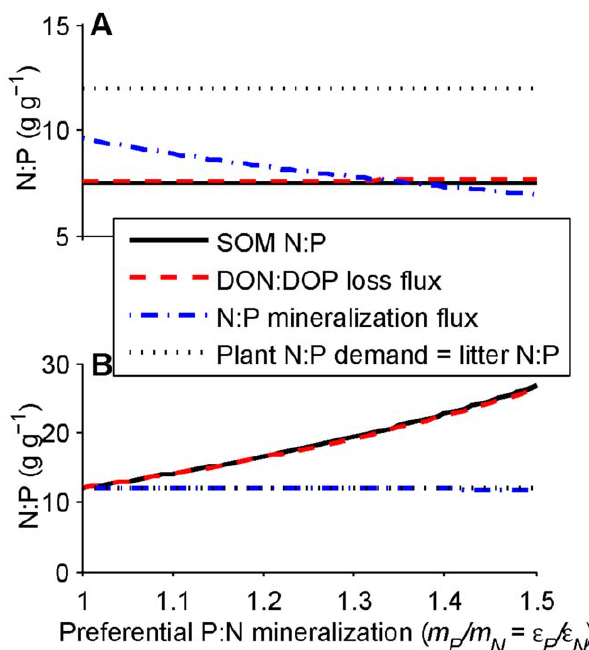
Figure 6. Effects of preferential P versus N mineralization. Effects are different for the (A) intermediate and (B) long timescales. Parameters are from Table 1 except for the mineralization rates m N and m P and the fractions of litter N and P decomposition mineralized, e N and e P , which vary to give the ratios along the horizontal axis. Timescale approximations of soil organic matter (SOM) N:P (solid black line), N:P losses of plant-unavailable nutrients from SOM and litter combined (termed DON:DOP in the legend for brevity, but in reality incorporating dissolved and particulate hydrologic losses and erosion losses; red dashed line), N:P mineralization fluxes from SOM and litter combined (blue dashed-dotted line), and plant N:P demand (black dotted line; which here is equivalent to P use efficiency:N use efficiency, litter N:P, and plant uptake) are plotted. The near-1:1 correspondence between SOM N:P and DON:DOP stems primarily from the equivalence of Q N and Q P , which is not always true (see Table 2 and [37]). However, any monotonic relationship would yield the same timescale dynamics exhibited here.